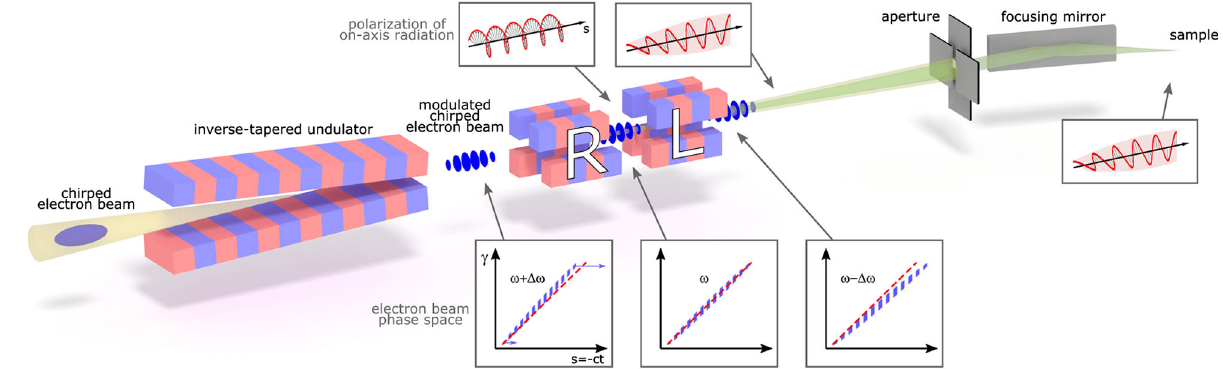
FIG. 3. Illustration of the scheme optimized for temporal polarization shaping or linearly polarized radiation. The density-modulated electron beam with a linear energy chirp sequentially radiates in the right- and left- handed helical undulators. Radiation frequency is determined by the bunching frequency, which changes upon passing through undulators. It is illustrated as “ stretching ” of the electron beam in comparison to a reference dashed line on the bottom inlays. This way one can obtain radiation with temporally shaped linear